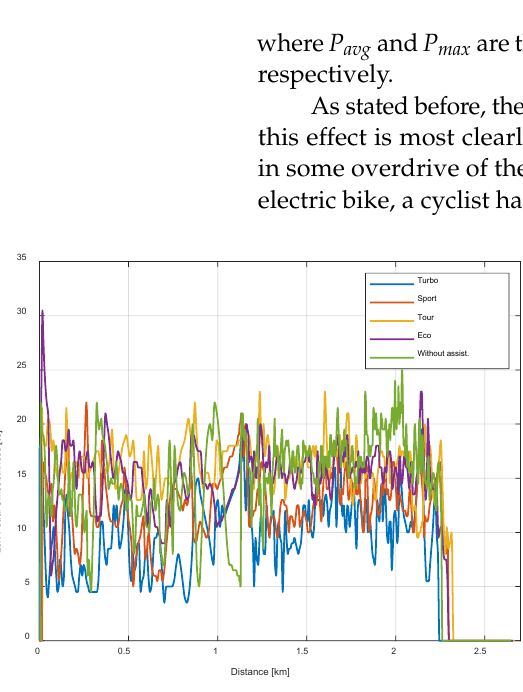
Figure 15. Left/right pedal smoothness.